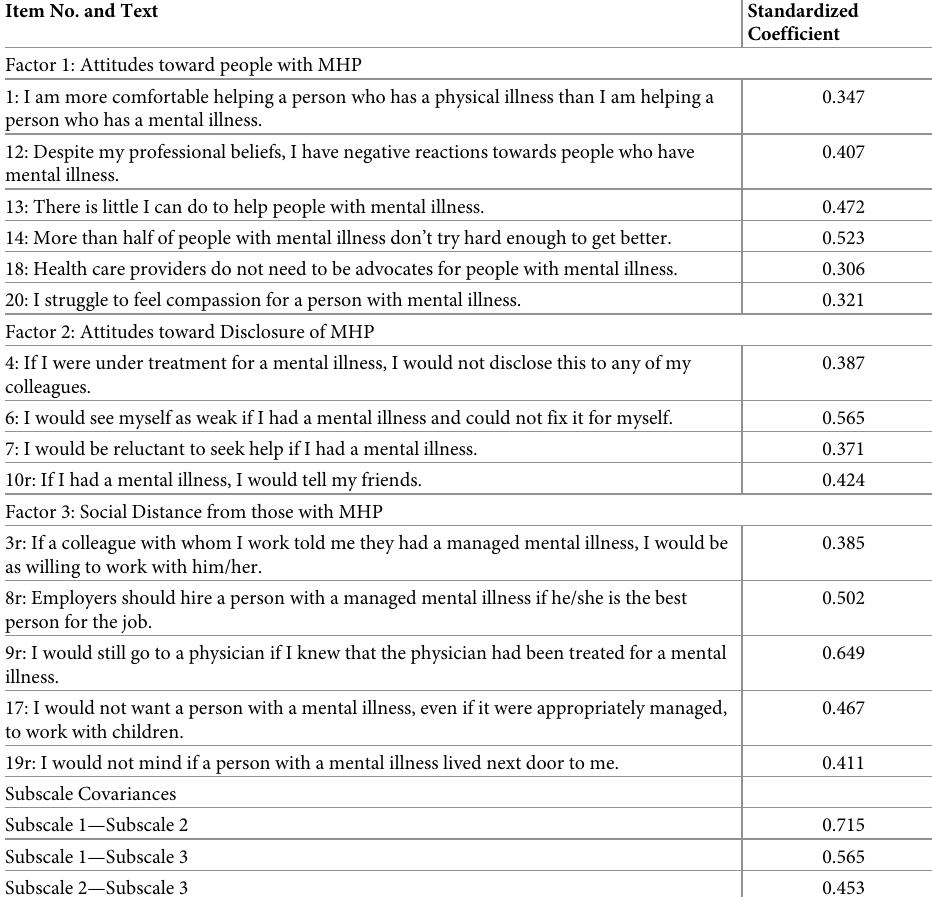
Table 2. Item loadings from confirmatory factor analysis in Opening Minds Scale for Health Care Providers (OMS-HC). Item No. and Text